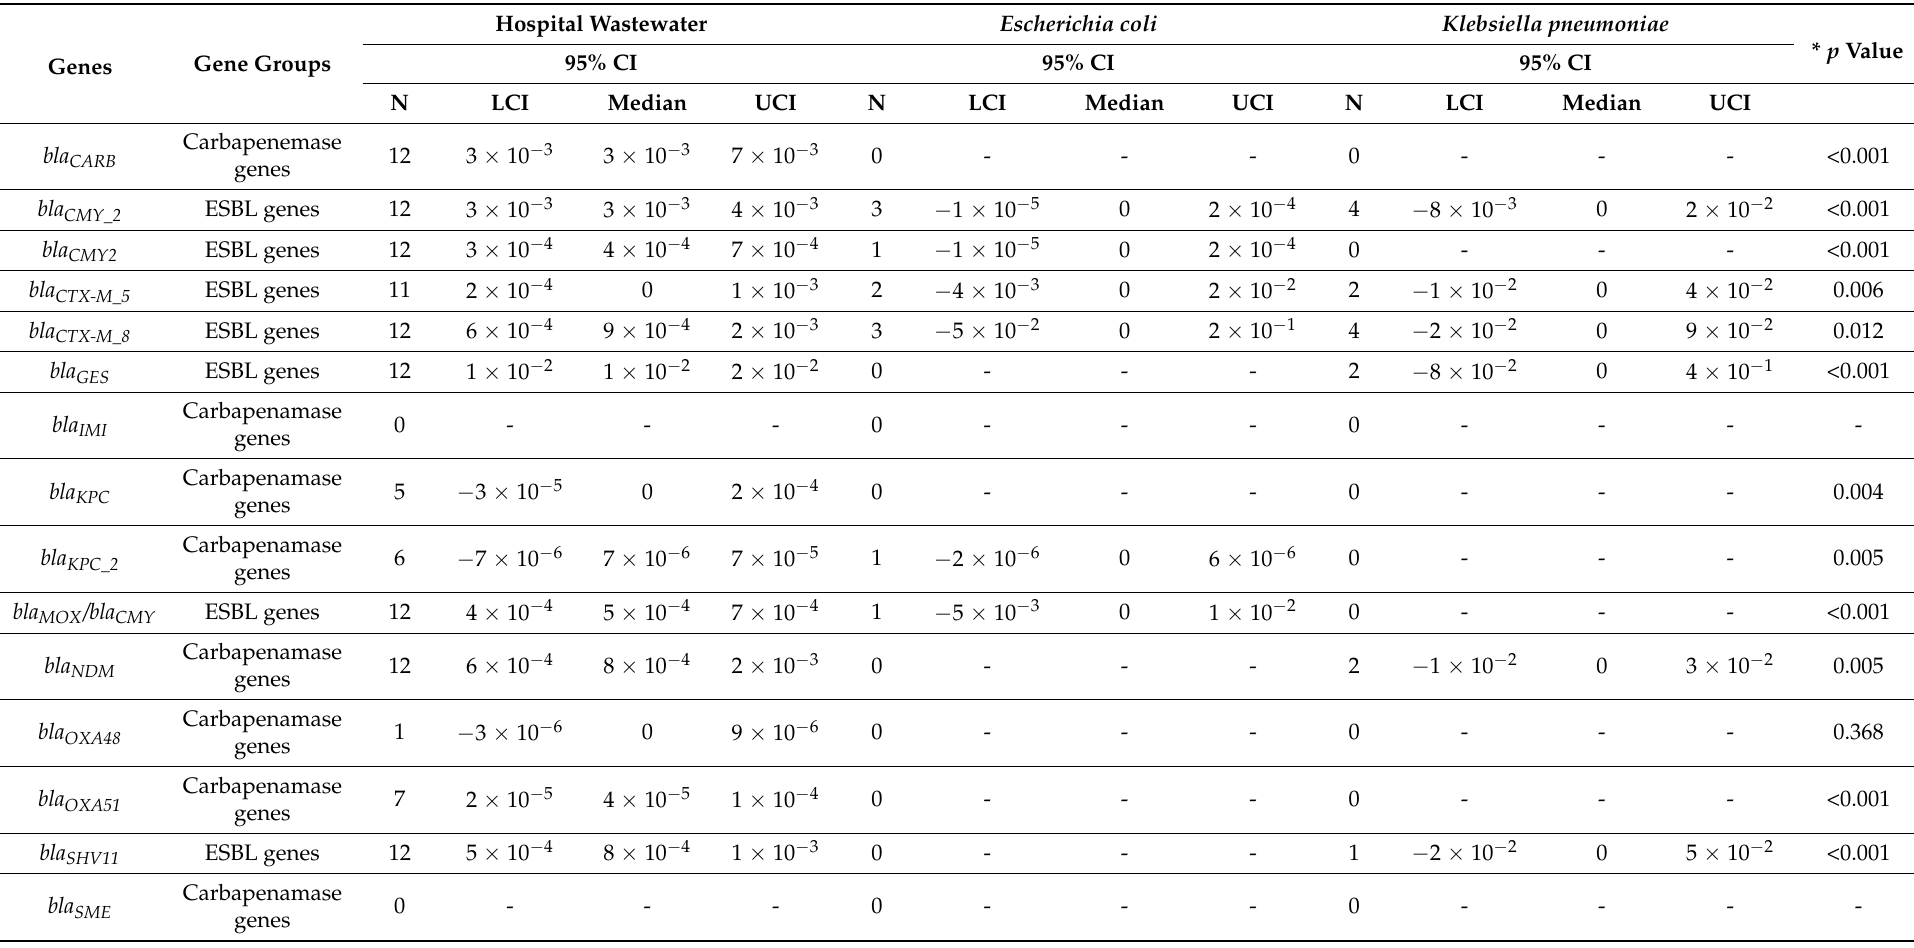
Table 3. Abundance of beta-lactam resistance genes in hospital wastewater and nosocomial pathogens isolated from hospital wastewater (copies/16s rRNA gene